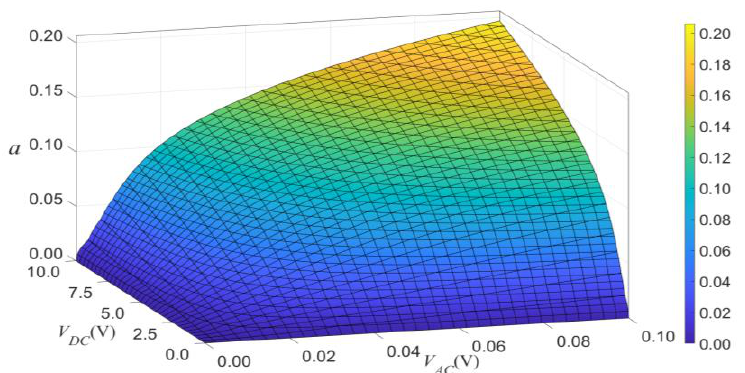
Figure 17. The 3D plot of amplitude of the response as a function of the load’s amplitude of primary resonance for σ = 0.